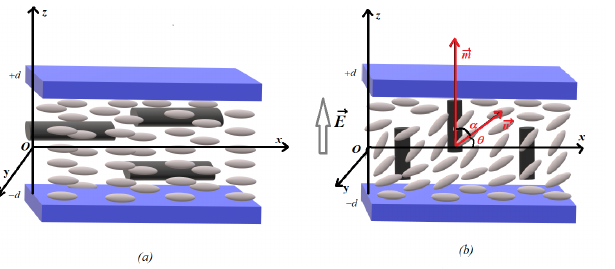
Figure 1. Molecular orientation in nematic liquid crystal with ferroparticles insertion ( a ) without an applied field and ( b ) with an electric field applied. The molecules and ferroparticles are oversized compared to the glass cell for a better understanding of